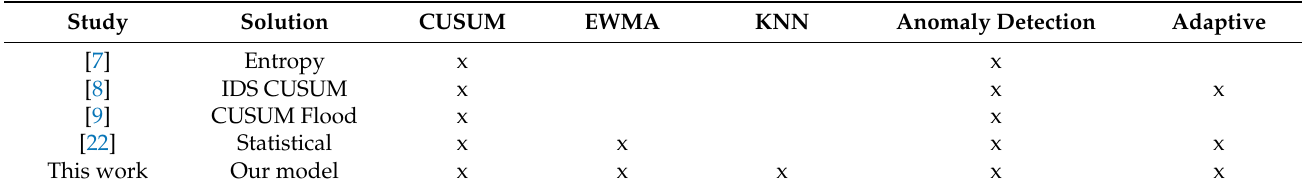
Table 2. Comparison of the implemented work with related